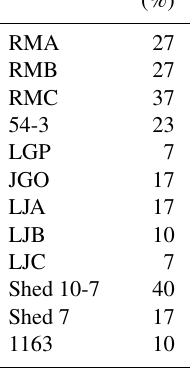
Table 8. Probability of detection of each individual path (POD path ) to the regional avalanche chronology.